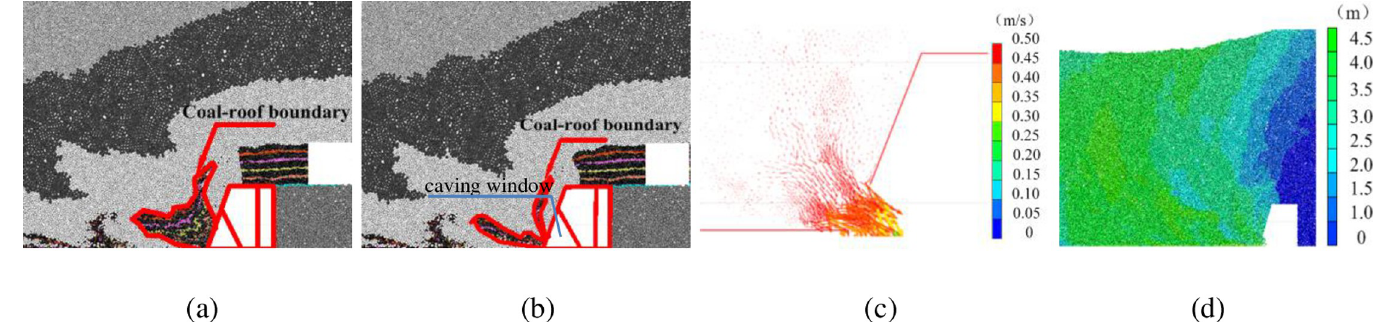
https://doi.org/10.1371/journal.pone.0283883.g005